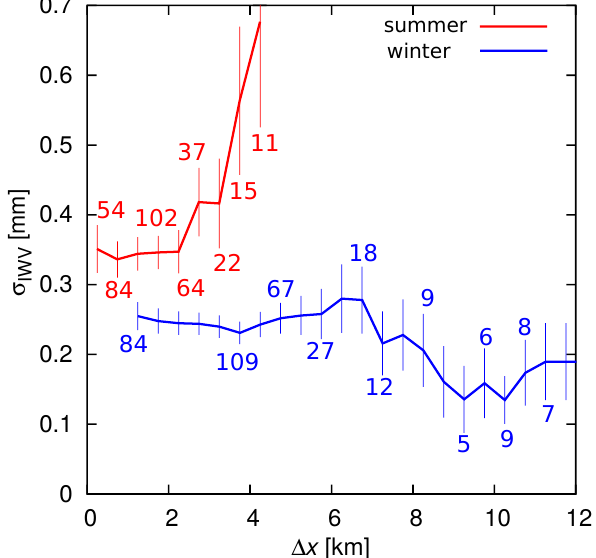
Figure 3. σ IWV as a function of the horizontal distance (cid:49)x between the center of gravity of FTIR IWV and DIAL IWV in the summer season (red) and in the winter season (blue). The coincidence time interval (cid:49)t is 60min for the blue curve and 30min for the red curve. For geometrical reasons, the shortest distance in the winter season is 1km. The number of measurement pairs from which σ IWV was calculated is indicated by the numbers near the curves (not for all nodes). The uncertainties ( ± σ ) are indicated by the error bars (for calculation see text).